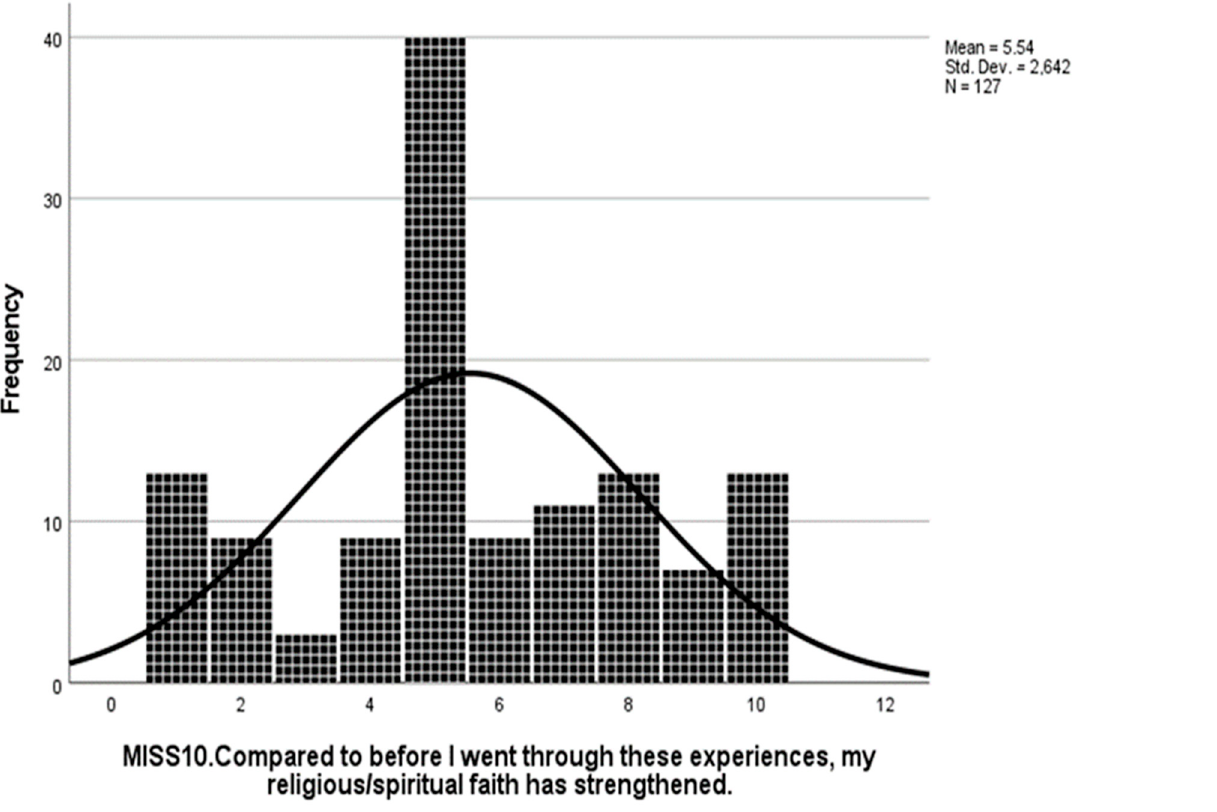
Figure 5. Frequency distribution of MISS10 in the original study by Mantri et al., when the partici- pants, who omitted the item after they had read it, were treated as missing values [19].